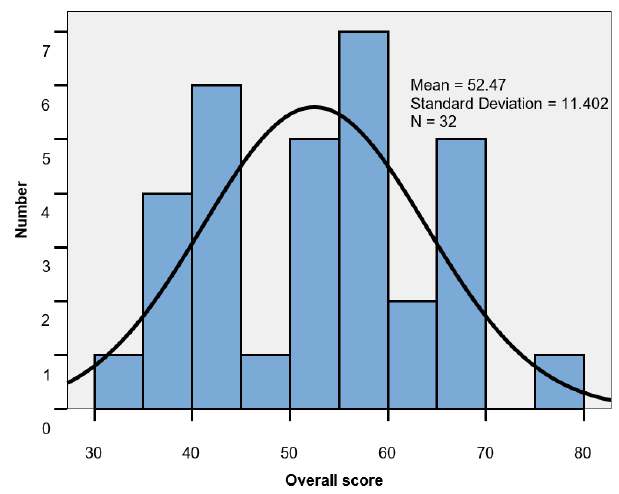
Figure 5. Global score histogram.